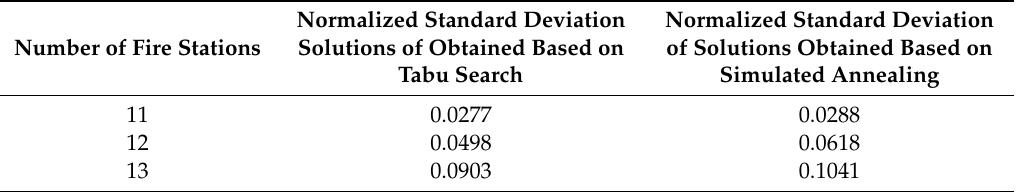
Table 3. The normalized standard deviation of solutions obtained using the VAOMP model with both algorithms.